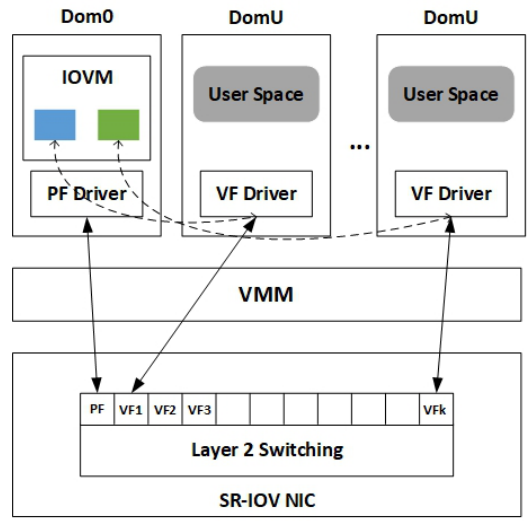
Figure 2. Single-Root I/O Virtualization